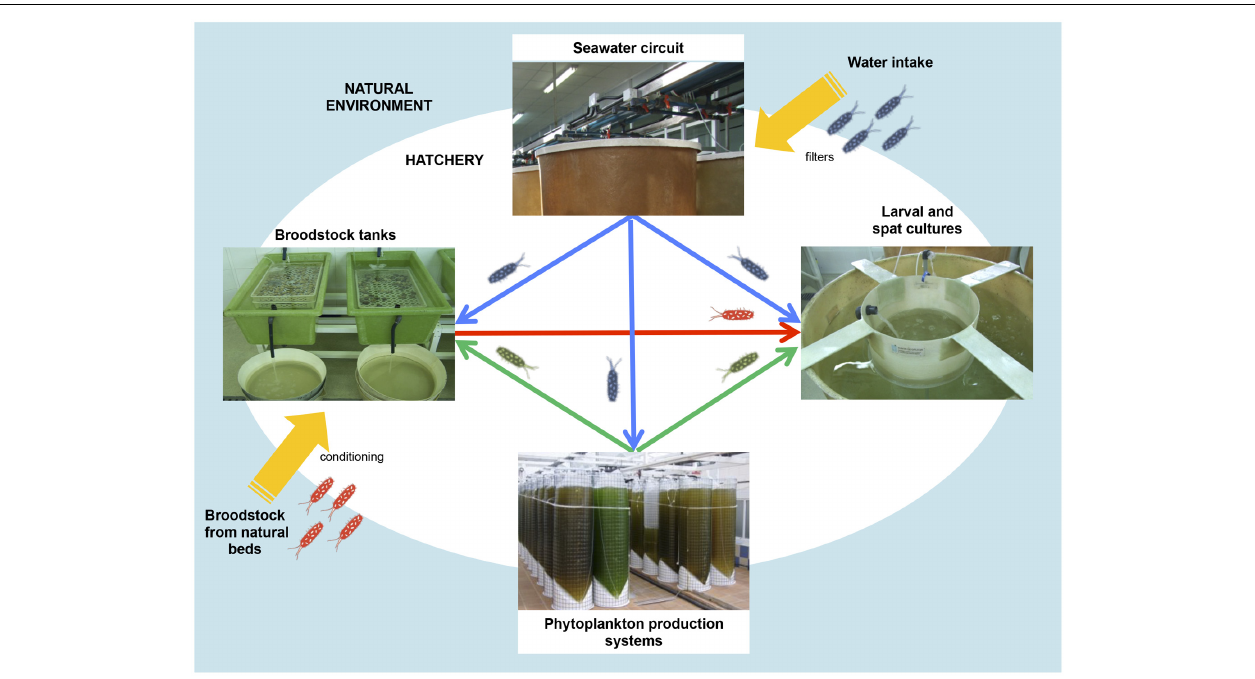
FIGURE 2 | Bacterial feedback among different hatchery compartments: broodstock conditioning tanks, phytoplankton production system, seawater circuit and larval and spat